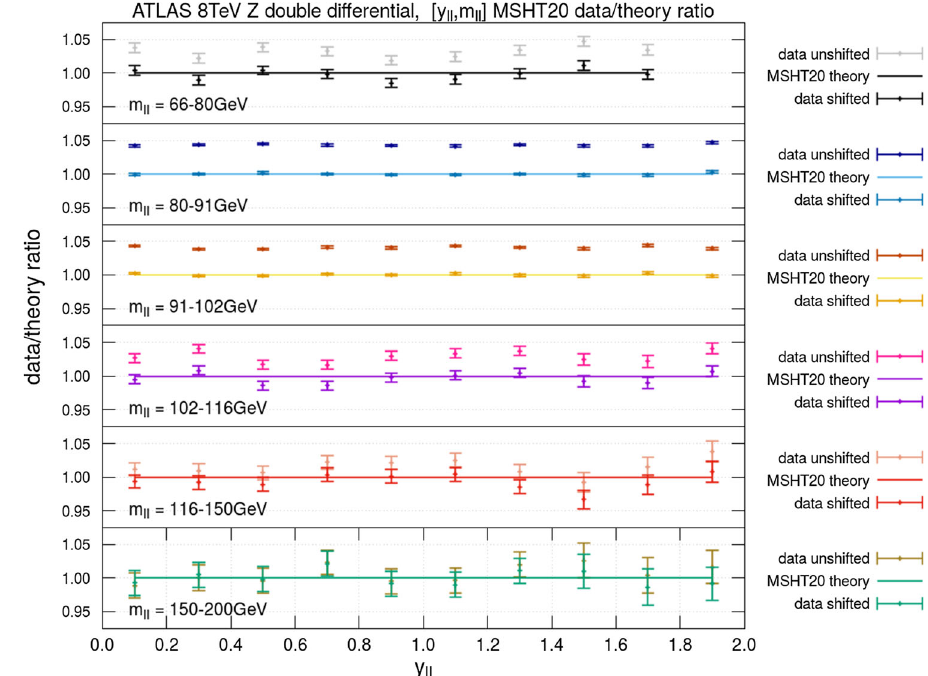
uncorrelated systematics and other error sources, and the red line is the MSHT20 theory prediction, with these data included in the fit. The errors plotted here are the total uncorrelated errors for each point